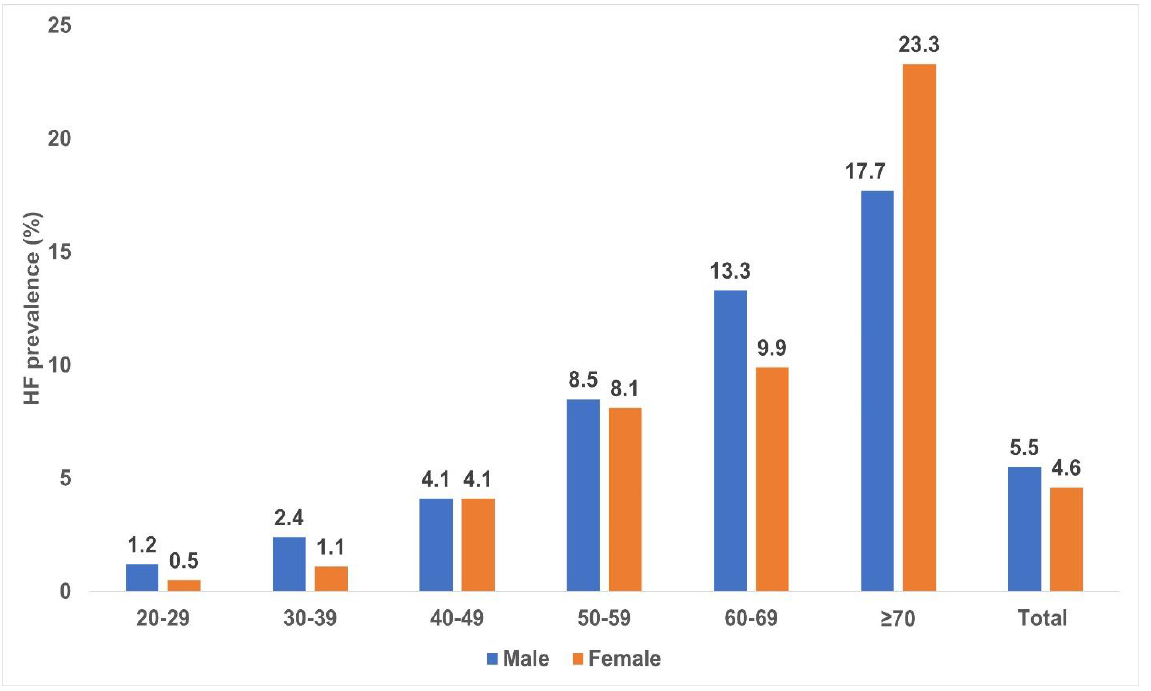
Figure 3. Age – specific prevalence of overall HF by gender. Figure 3. Age–specific prevalence of overall HF by